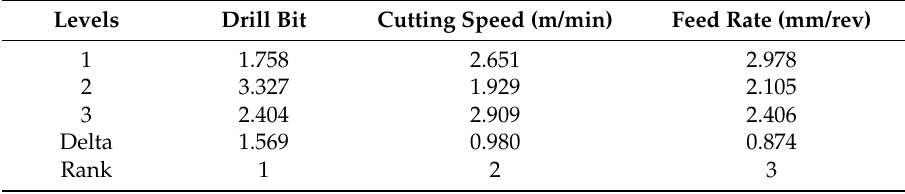
Table 5. S/N ratios response table (smaller is better) of surface roughness for (Mg/SiC/GNPs) MMC. Levels Drill